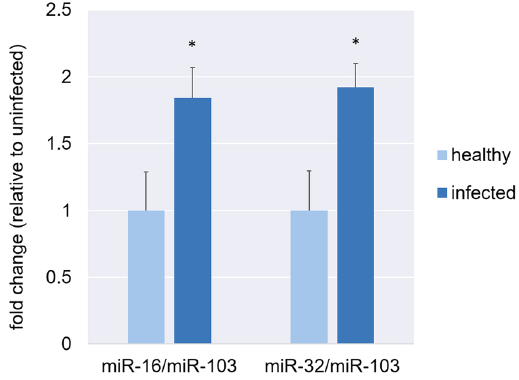
Figure 6. qRT-PCR validation of two miRNAs identified as differentially expressed by miRNA profiling. Graphs show relative expression levels of miR-16 and miR-32 in infected and uninfected samples. Data is normalized against relative levels of miR-103. Values were normalized to set the average for uninfected horses to 1. The difference between infected and uninfected groups was analysed in Graph Pad Prism software, using a two-tailed Student’s t test, with a P value of < 0.05 considered to be statistically significant. Error bars represent standard deviation of